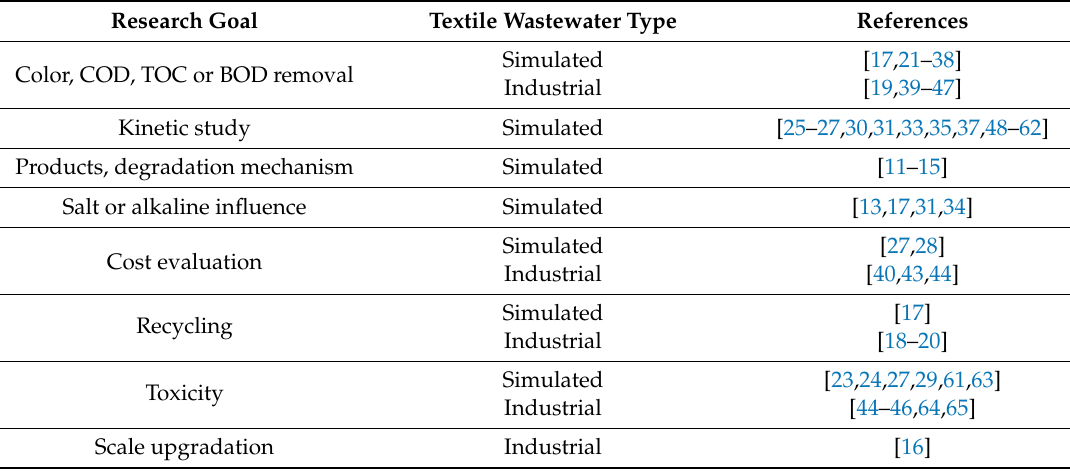
Table 1. Literature overview of simulated and industrial textile wastewater treatment by ozonation. COD, chemical oxygen demand; TOC, total organic carbon; BOD, biological oxygen